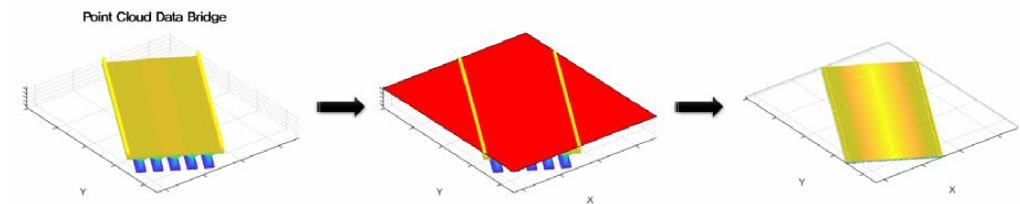
Figure 5. Example of the plane prediction for point cloud data